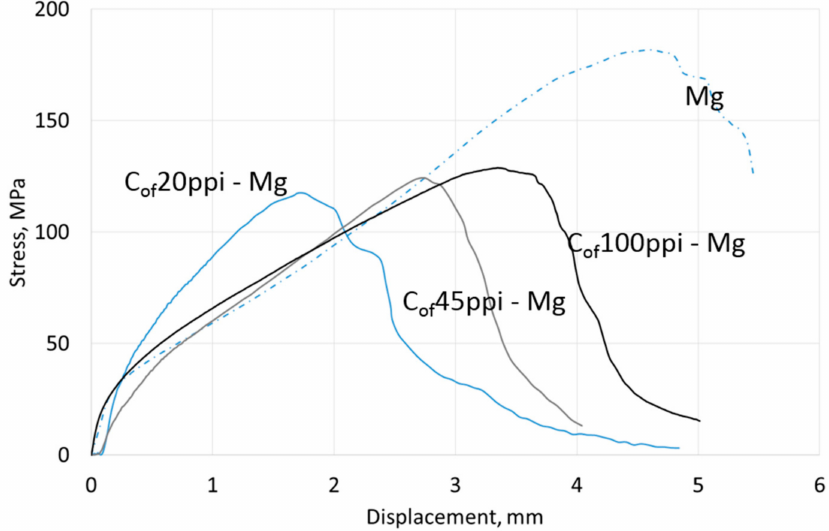
Figure 12. Representative curves obtained from three-point bending tests of Mg matrix composites with C of 20ppi, C of 45ppi and C of